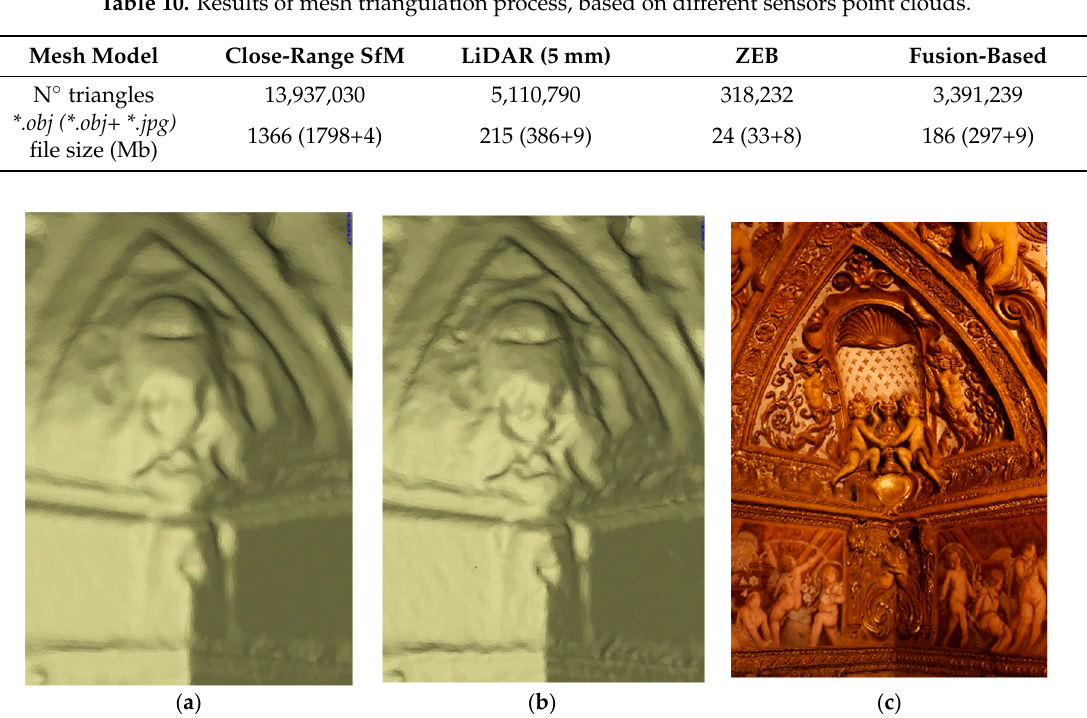
Figure 19. ( a ) The oriented images block in the Fleur-de-lis Chamber ; ( b ) The Photoscan Pro Graphic User Interface (GUI) allows for importing external integrated point cloud for the fusion-based mesh triangulation.